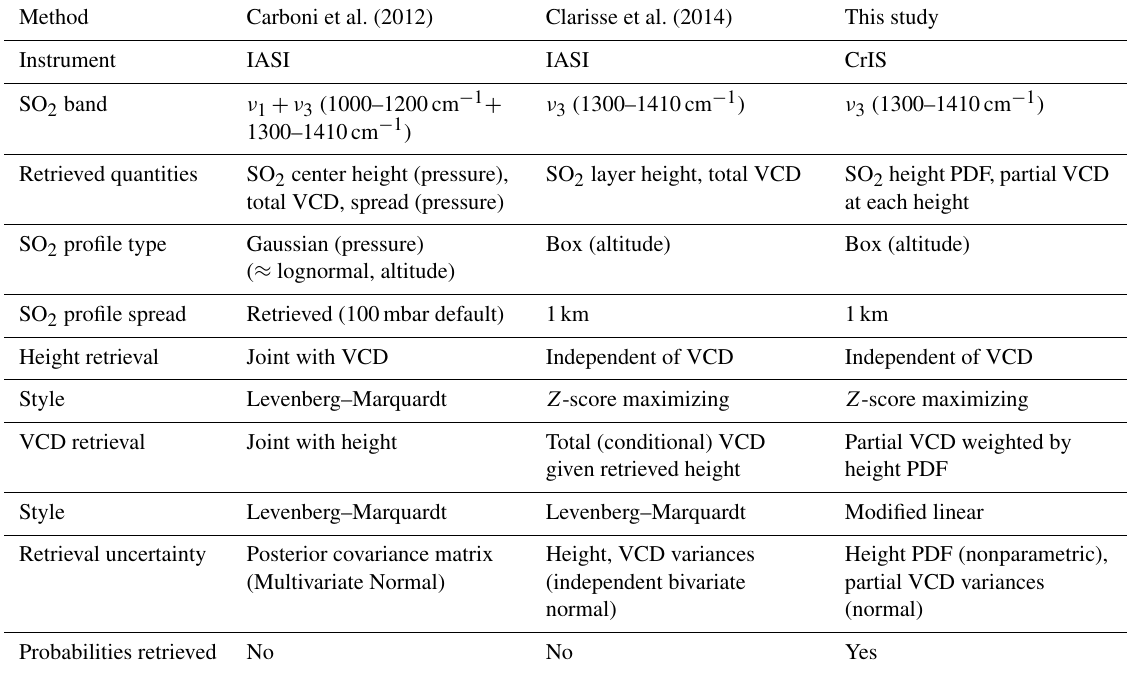
Figure 1. Flowchart showing the probabilistic framework for Monte Carlo height and VCD, yielding a PDF for the height, which is not generally Gaussian and may be heavily skewed, and a Gaussian distribution of conditional VCD ( ˆ X | H = h) . The height retrieval of Clarisse et al. (2014) is shown schematically as red lines, giving a single height estimate, which is not the mean height in general (approximately the dotted black line in the height PDF). As this figure is only a schematic, the pictorial relationship between these height estimates in not universal. Table 1. Summary of Recent Infrared SO 2 Height Estimation